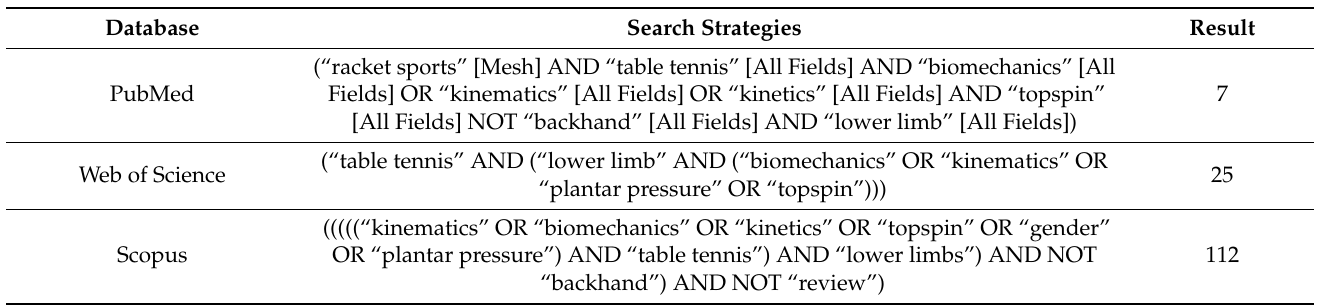
Table 1. Search strategies in each electronic